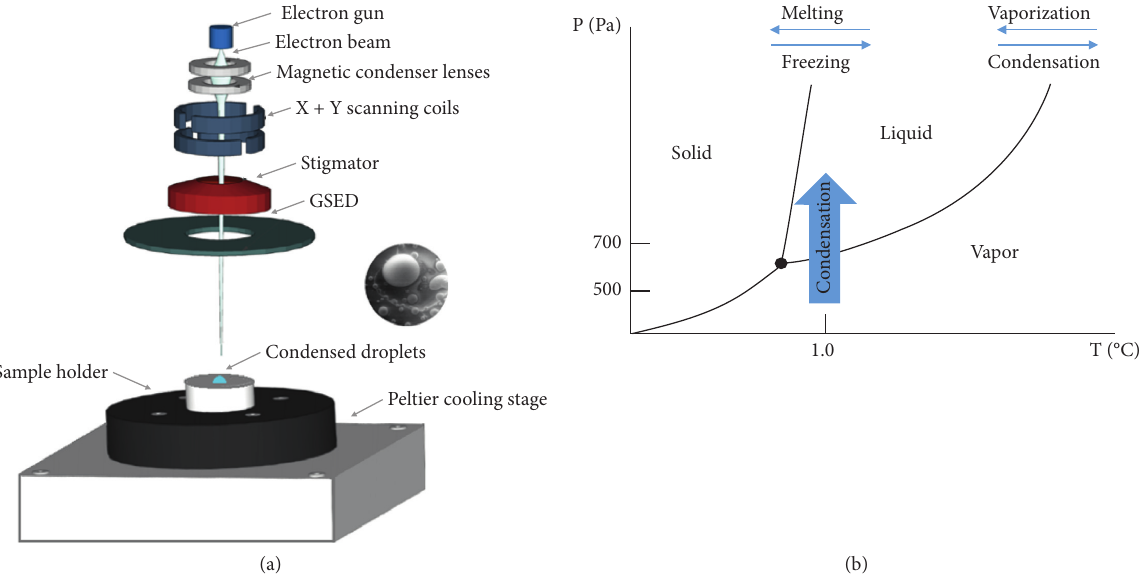
Figure 1: (a) Experimental setup for in situ water condensation (ESEM) [42]; (b) water condensation was achieved at a temperature of 1 ° C and increasing the pressure above 500 Pa.